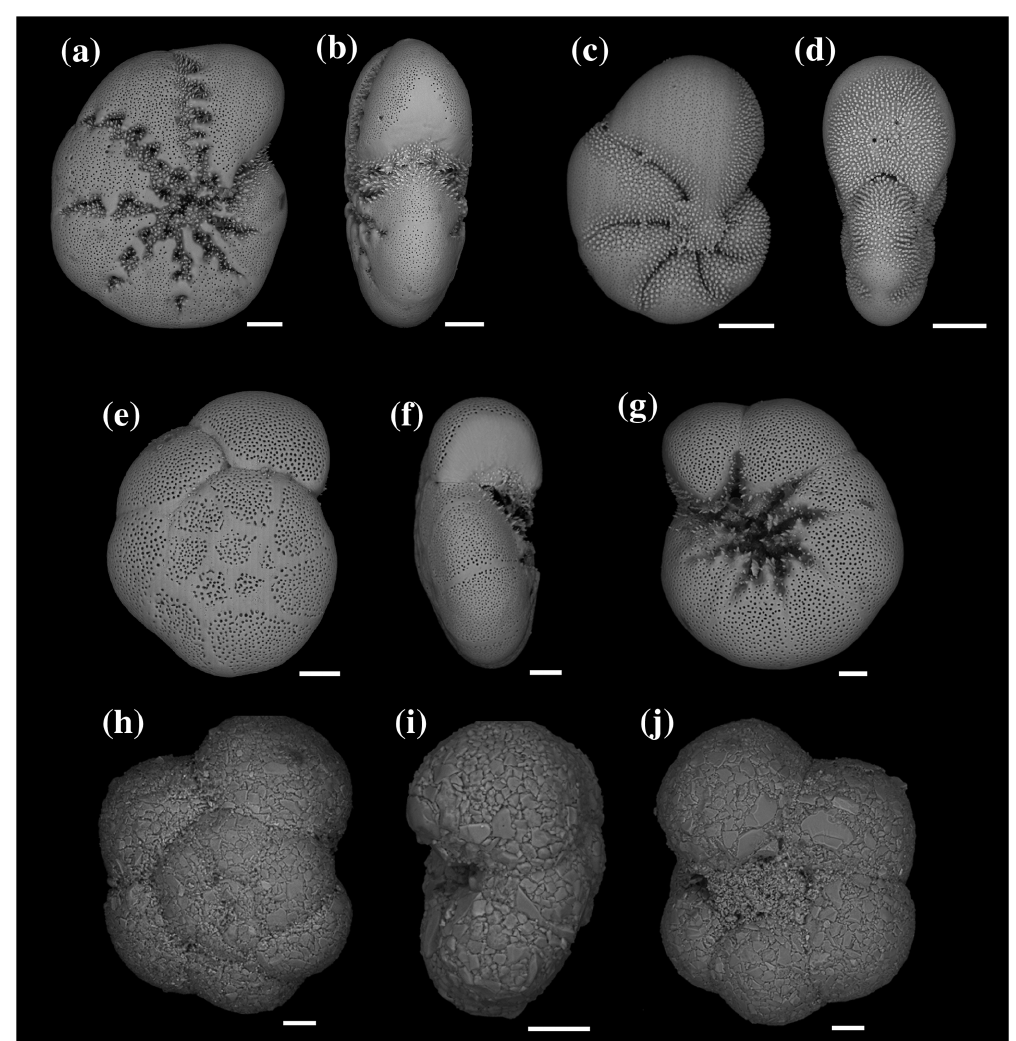
Figure 4. SEM images of Elphidium selseyense in lateral (a) and peripheral (b) views; Elphidium magellanicum in lateral (c) and periph- eral (d) views; Ammonia sp. T6 in spiral (e) , peripheral (f) and umbilical (g) views; and Trochammina inflata in spiral (h) , peripheral (i) and umbilical (j) views. All scale bars are